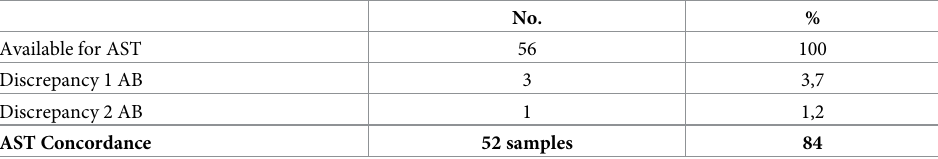
Table 6. Evaluation of 56 samples available for dAST.